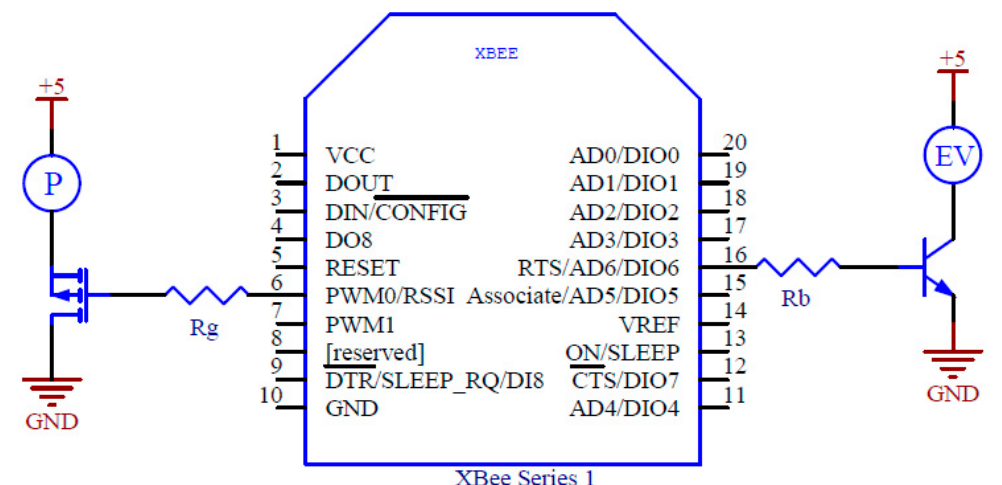
Figure 7. Electrical diagram of the activation circuits of the pump and the electrovalve (PV2, PV3, and